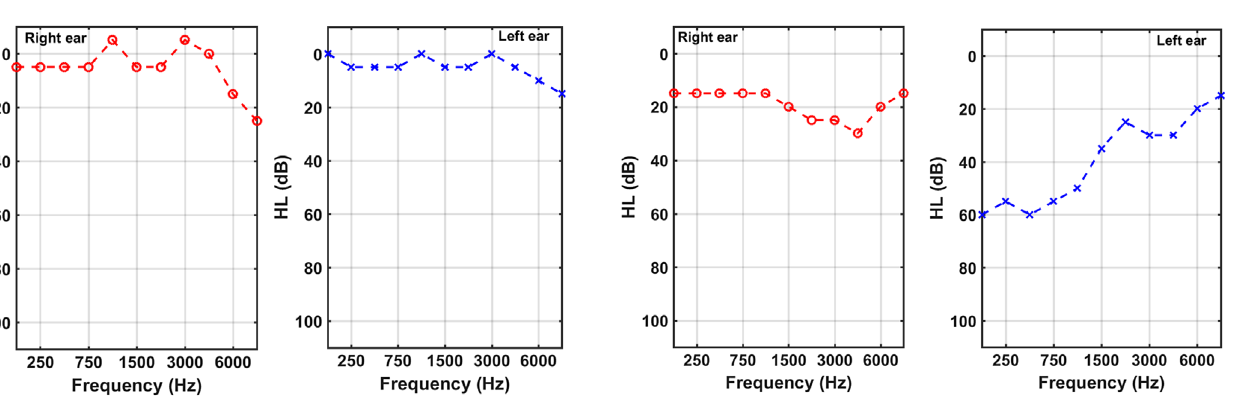
Figure 9. Right and left pure tone audiograms of a participant #1.